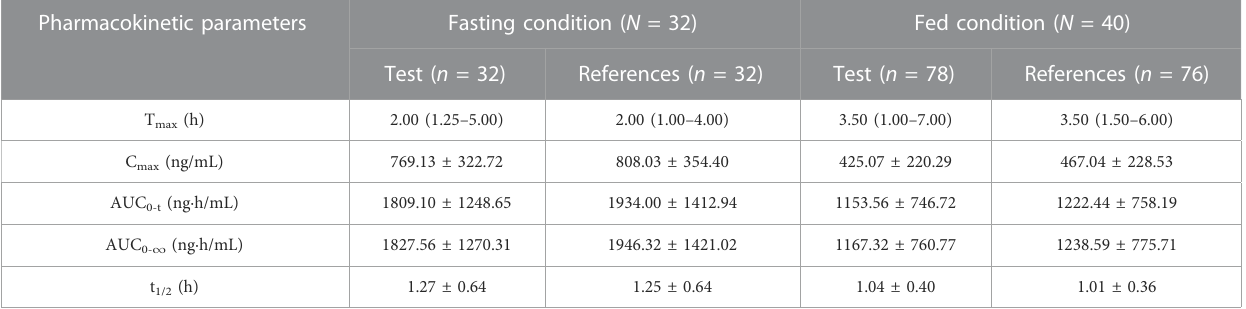
TABLE 2 Pharmacokinetic parameters of esomeprazole after a single dose 20 mg of test and reference esomeprazole magnesium enteric-coated tablet in healthy Chinese subjects under fasting and fed conditions.